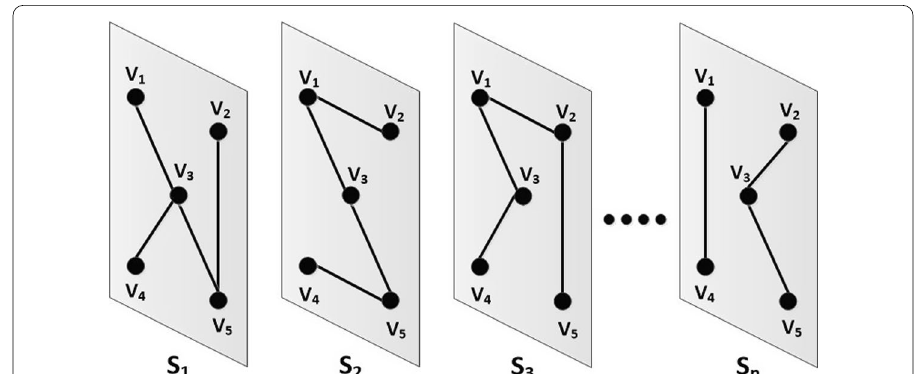
Fig. 1 Satellite network topology based on time slices